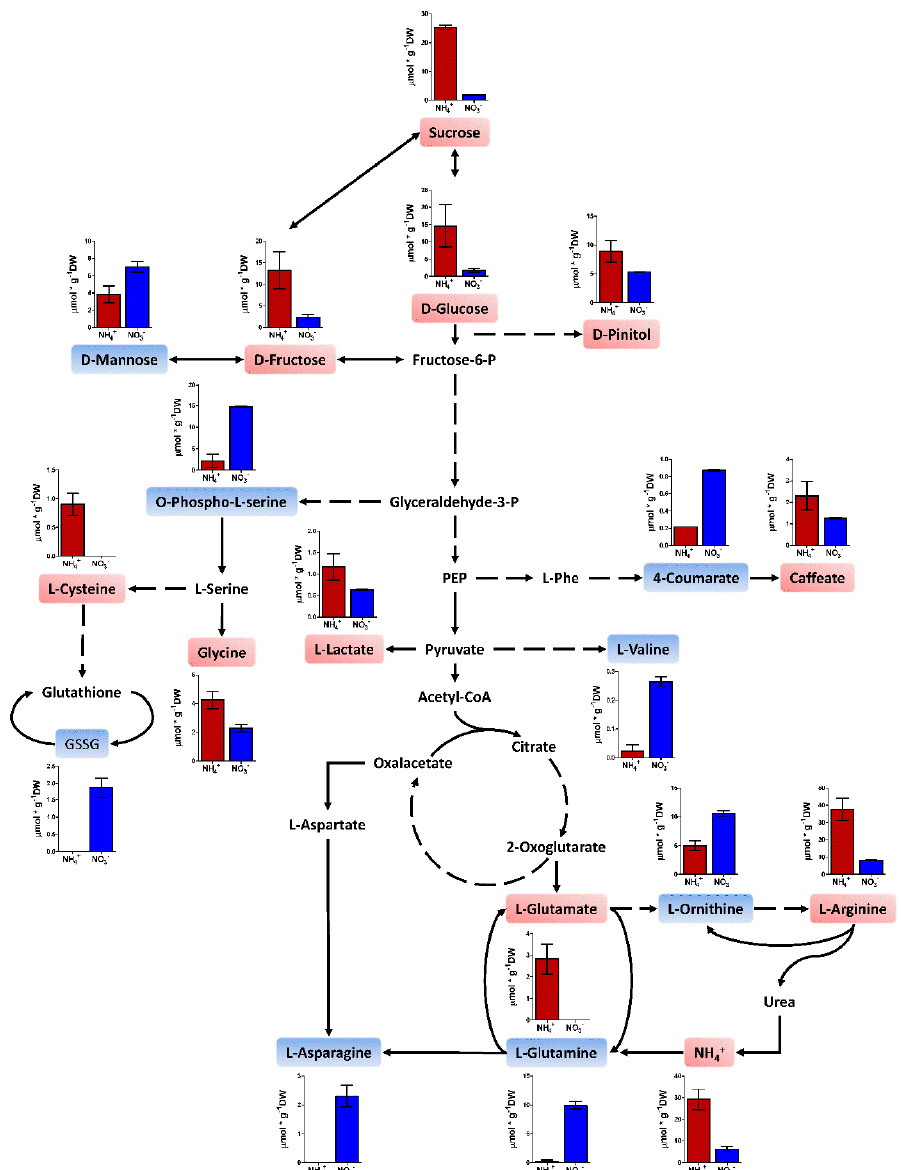
Figure 6. Main significant metabolites in the roots of seedlings fed 8 mM ammonium or 8 mM nitrate. Red columns correspond to 8 mM NH 4+ supply; blue columns correspond to 8 mM NO 3 − supply. Metabolites highlighted in red were significantly more accumulated in the roots of seedlings fed 8 mM